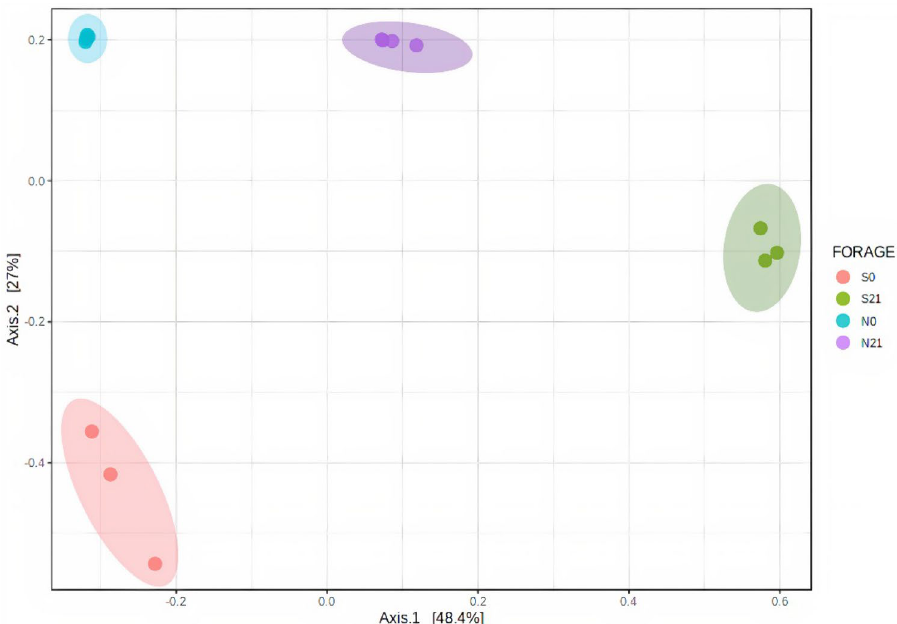
Figure 4. Principal coordinate analysis (PCoA) derived from the Bray–Curtis distance between fresh forage and silage of sweet corn and Napier. Coloured dots represent different forage crops. PERMANOVA value, F-value: 107.71, R-squared: 0.96998, p- value < 0.001 (S0, Fresh sweet corn; S21, Sweet corn silage; N0, Fresh Napier; N21, Napier silage).